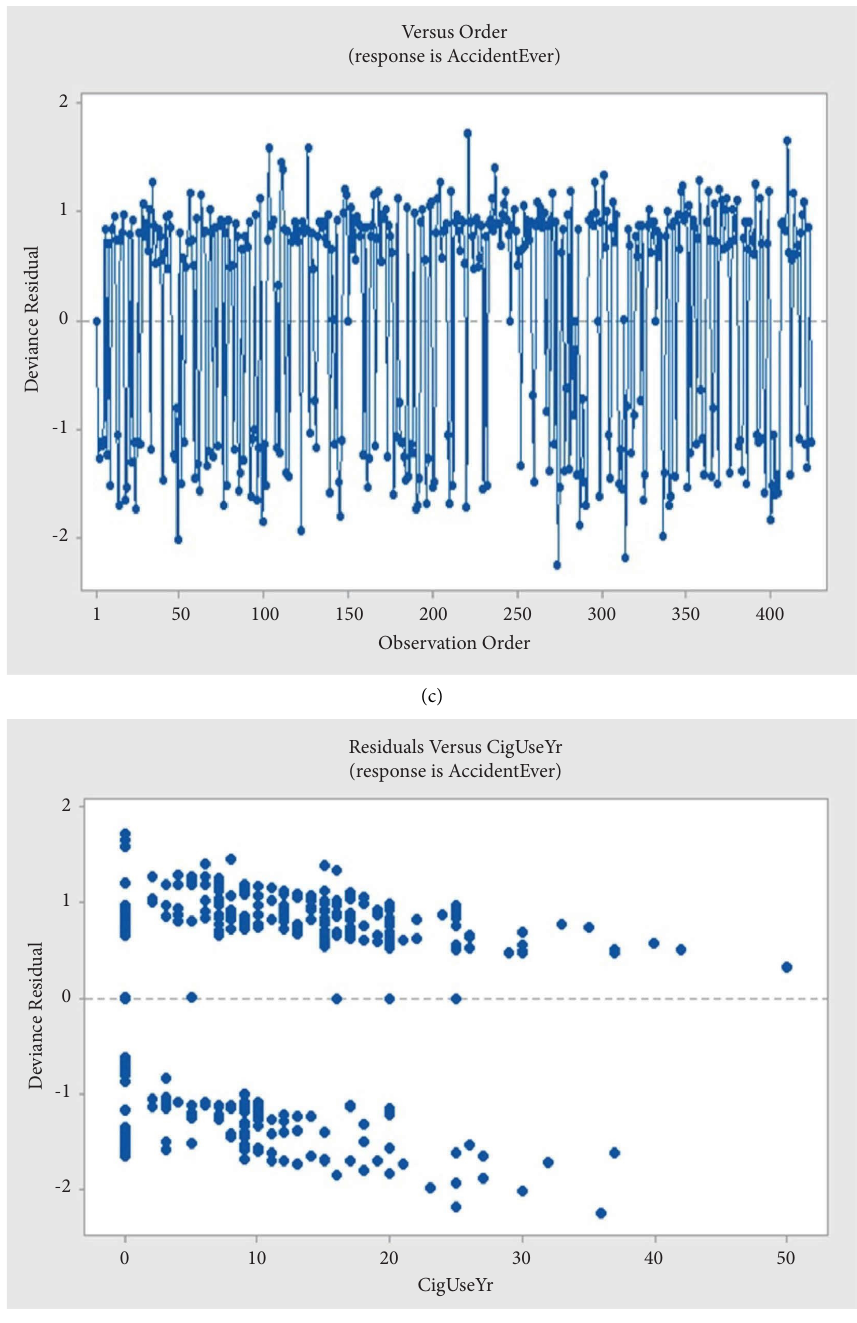
Figure 5: (a) Normal probability plot, (b) histogram of frequency versus deviance residual of the binary logistic regression model, (c) versus order plot, and (d) deviance residuals versus